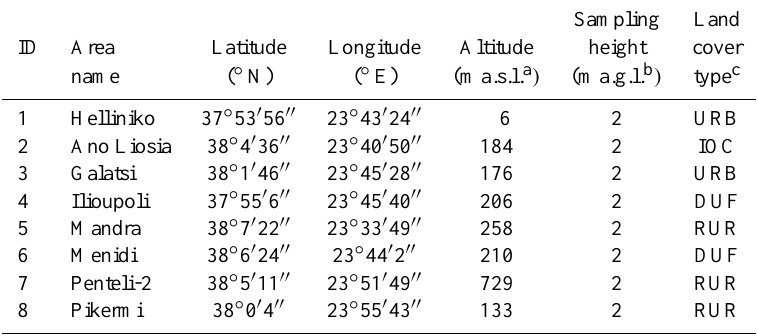
Table 3. Characteristics of the measurement sites used for the evaluation of the modeling system.